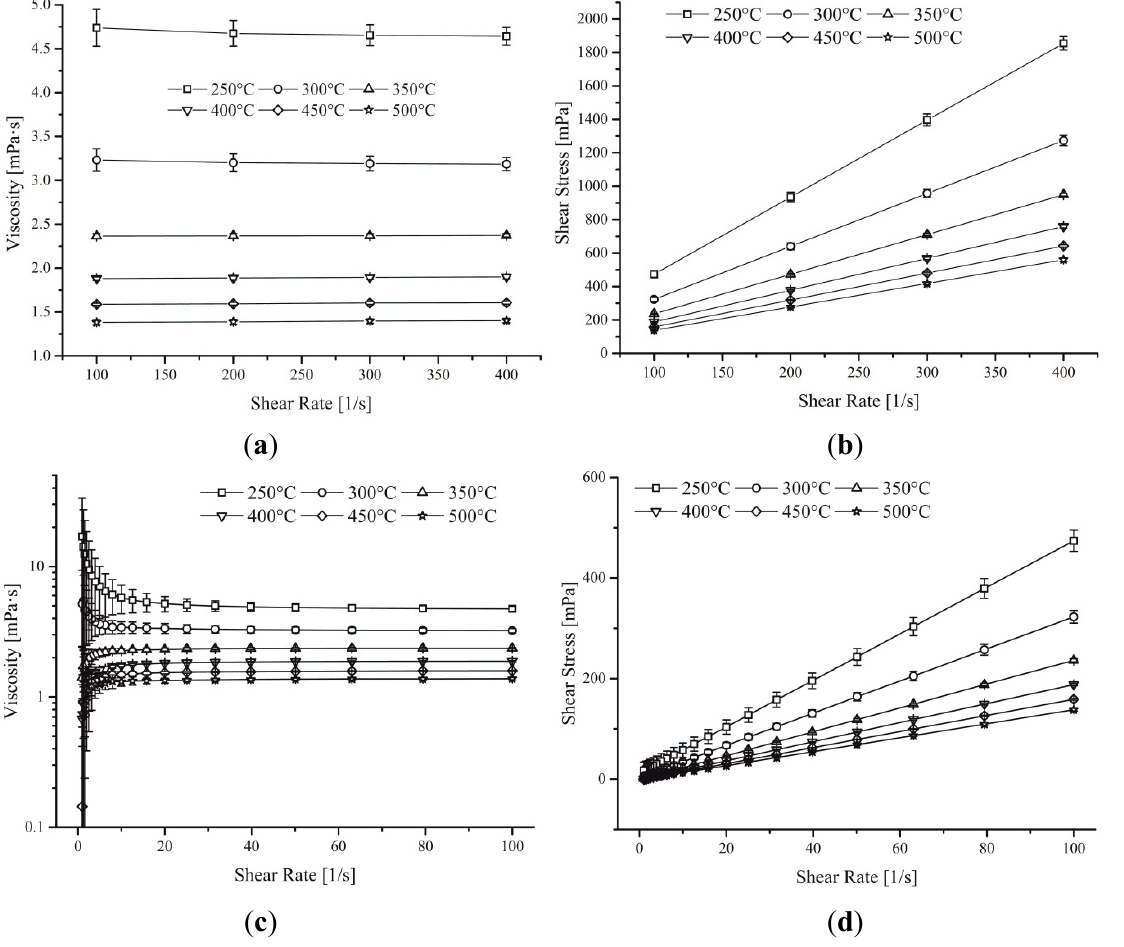
Figure 3. ( a ) and ( b ) graphs show the effect of viscosity and shear stress against changes in shear rate (100 s –1 to 400 s –1 ) for different temperatures. ( c ) and ( d ) graphs display the effect of viscosity and shear stress against decreasing shear rate from 100 s –1 to 1 s –1 (Value below 20 s –1 were discarded due to low torque